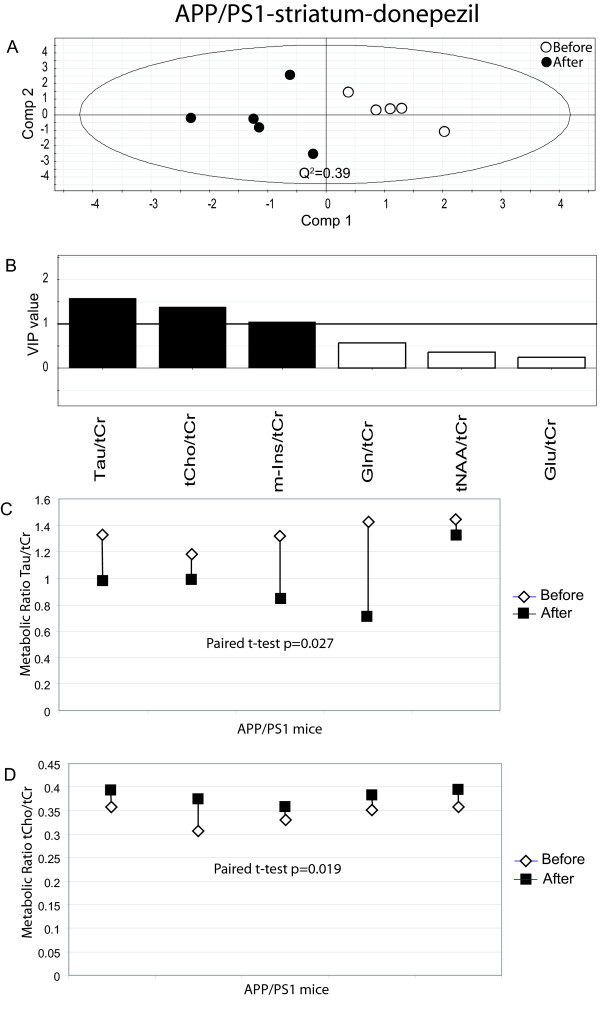
Results from the data analysis of donepezil treated APP/PS1 (striatum). (A) PLS-DA scatter plot which displays a clear separation between mice before and after donepezil treatment (white circles = before treatment and black circles after treatment). Each data point represents one mouse. A Q2-value above 0.05 indicates that the groups can be significantly distinguished along that component. (B) Metabolites which are important for the separation between groups in the PLS-DA model. VIP (variable of importance in the projection) values larger than 1 are relevant in explaining group differences (black bars) while metabolites with values below 1 have no significant impact (white bars). (C) The paired t-test shows a significant decrease in Tau, p = 0.027. White diamonds represents before treatment and black squares after treatment. (D) The paired t-test shows a significant increase in tCho, p = 0.019. White diamonds represent before treatment and black squares after treatment.